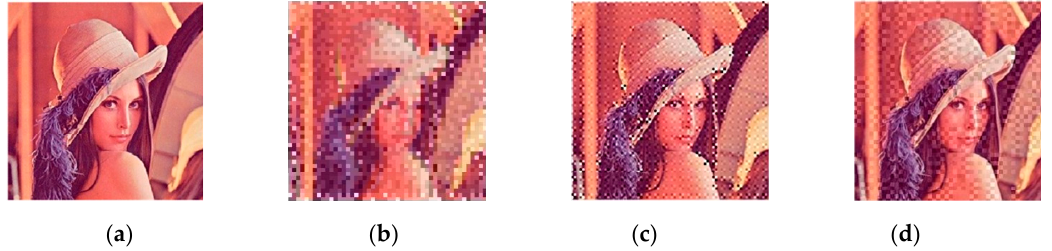
Figure 11. The perceptual quality of aesthetic 2D barcodes with Lena: ( a ) Carrier image, ( b ) SRA code [28] with the threshold δ = 20, ( c ) RA code [31] with δ = 20, and ( d ) our code with δ = 20